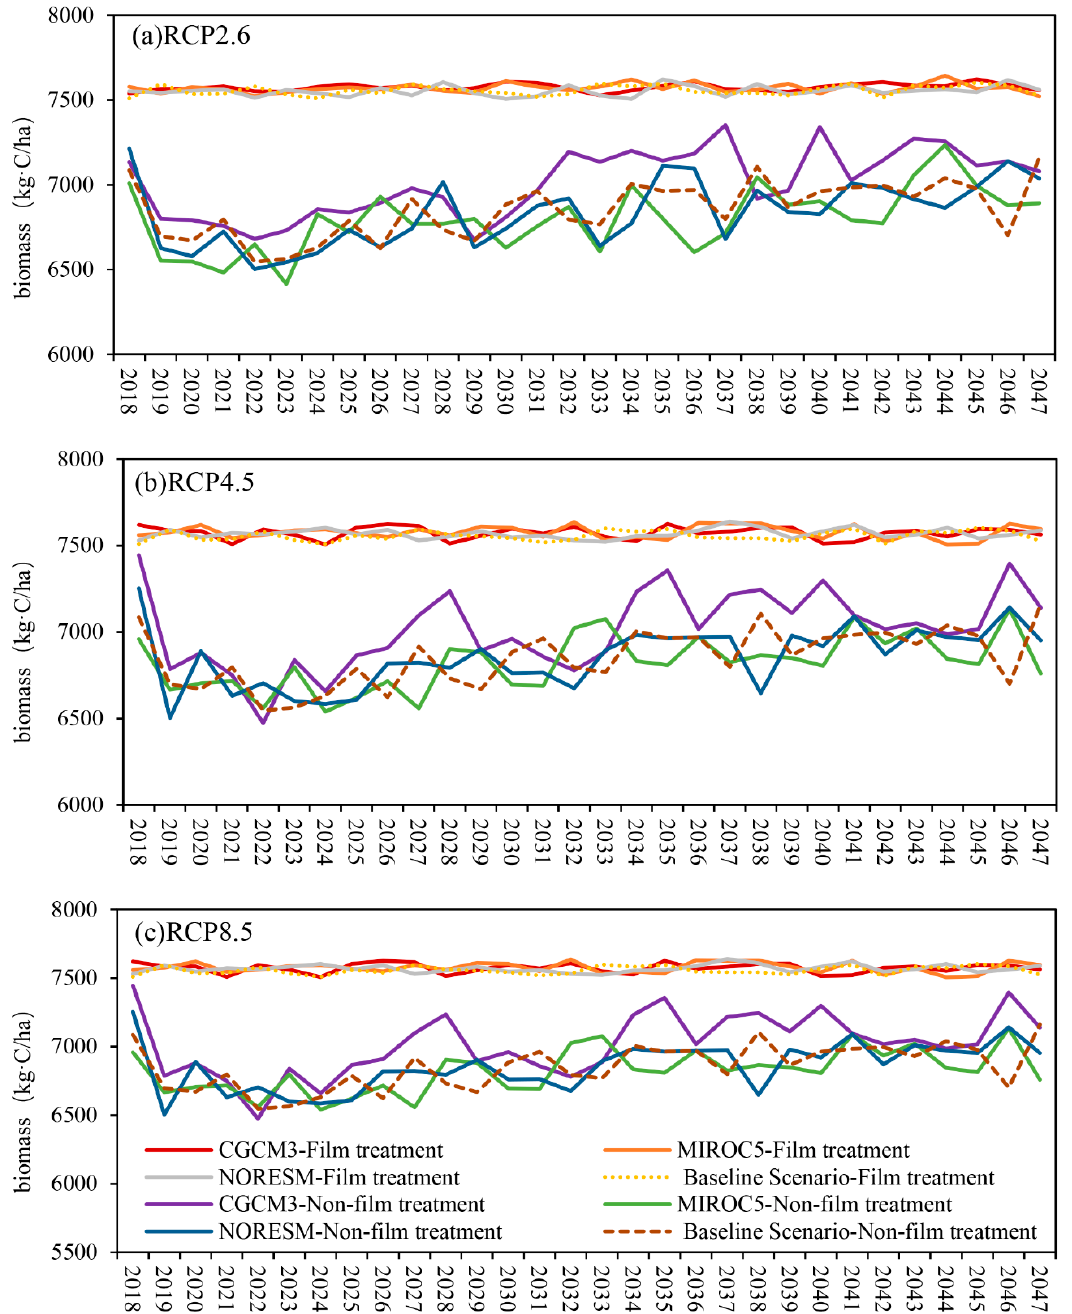
Figure 7. Maize biomass predictions for degradable mulch film and bare land treatment scenarios for 2018–2047 under three levels of emissions ( a : RCP2.6, b : RCP4.5, c : 2018–2047 under three levels of emissions ( a : RCP2.6, b : RCP4.5, c : RCP8.5).